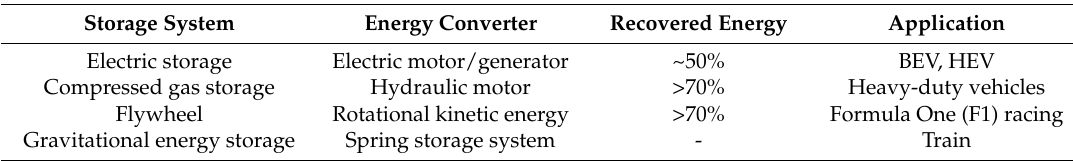
Table 30. Different methods of recovering energy during braking